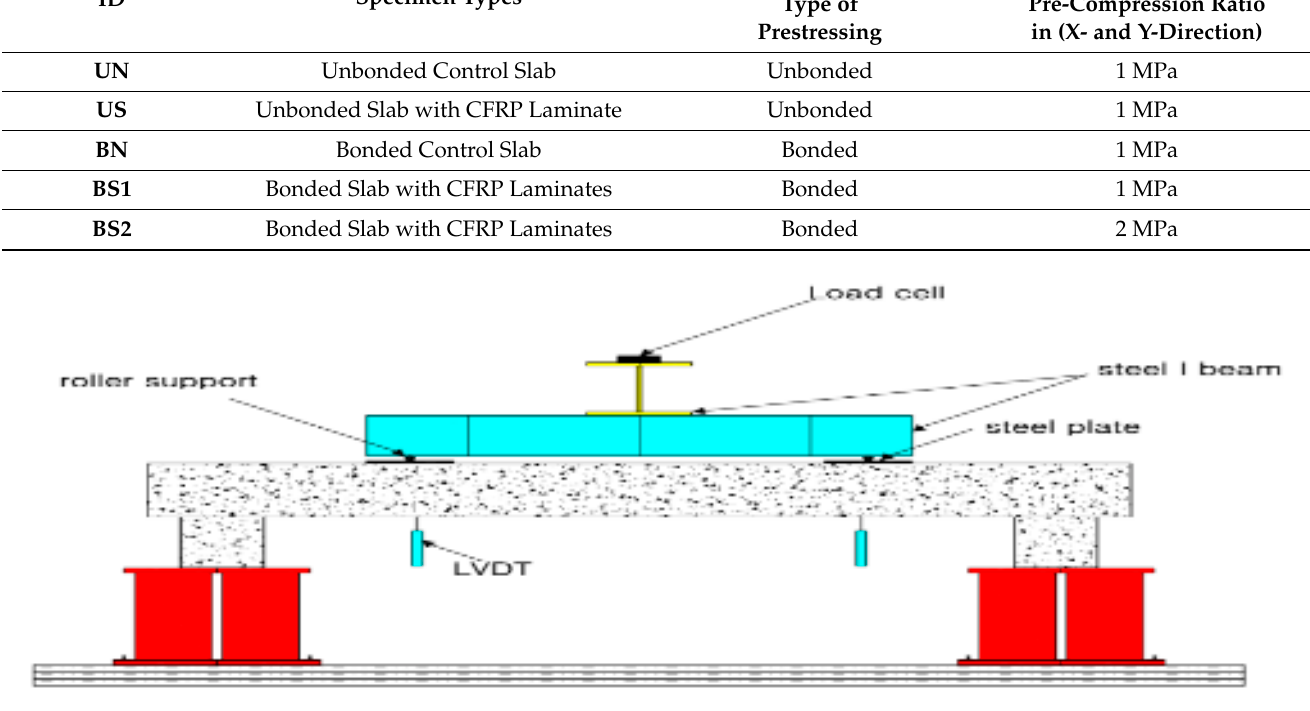
Figure 2. Test setup and instrumentation of slabs specimens [33].